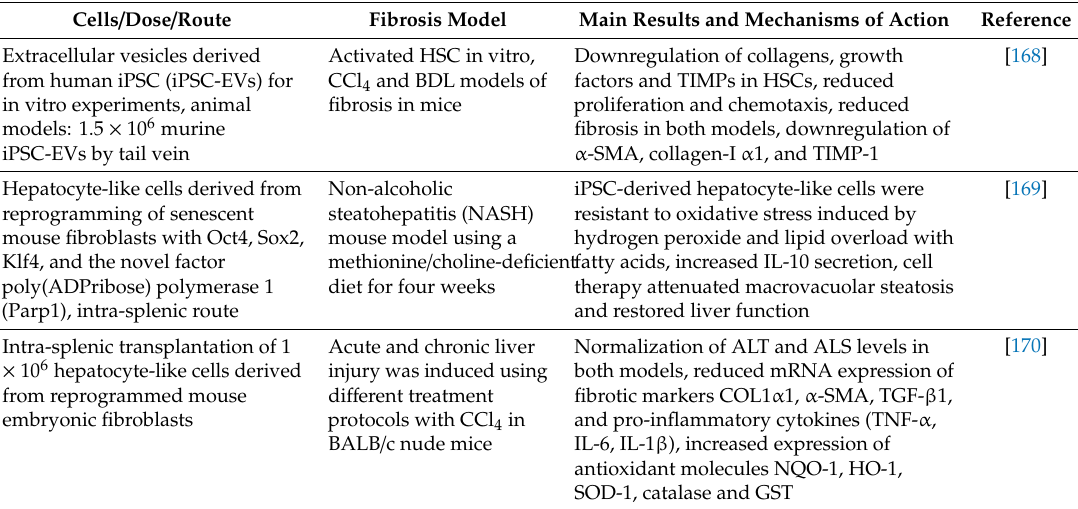
Table 6. Experimental liver fibrosis and pluripotent